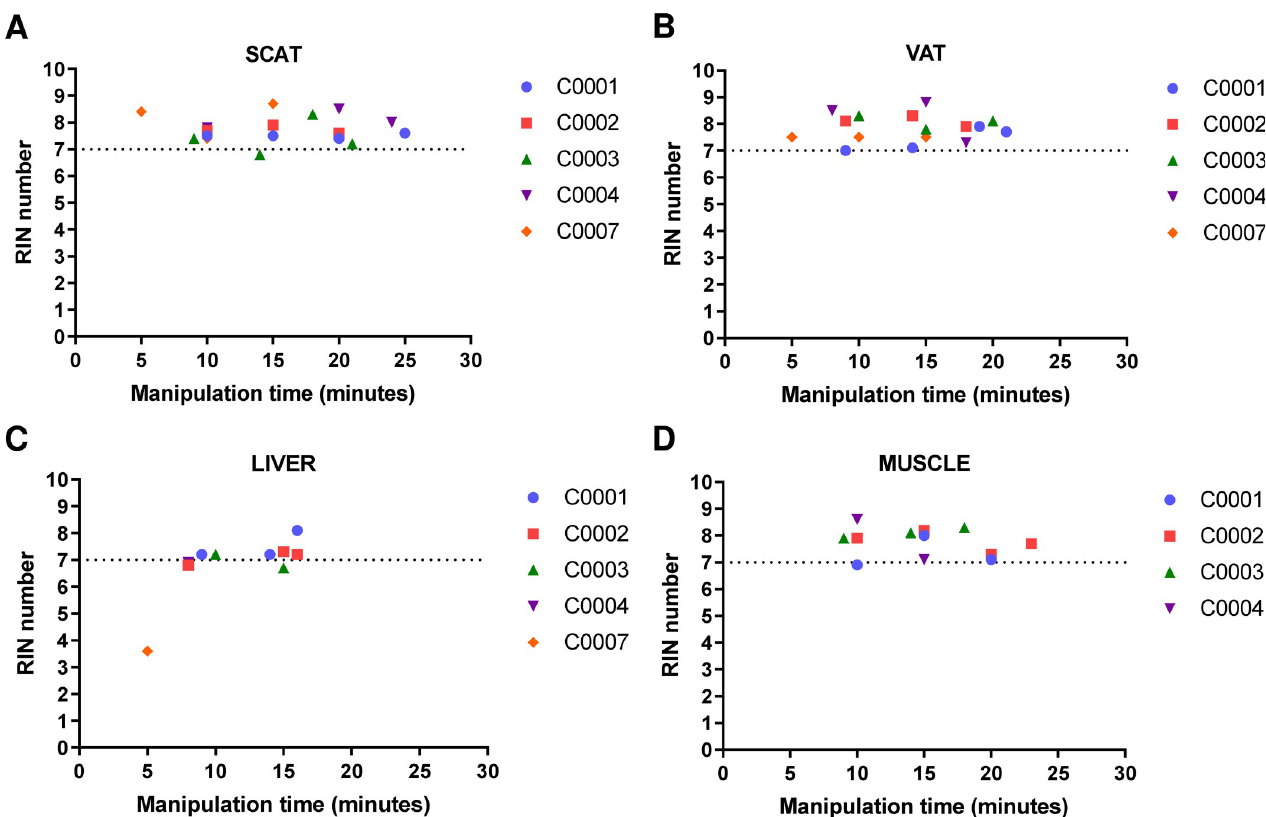
Fig 3. RIN according to handling time for tissue preparation for the first five patients. RNA was extracted from frozen tissues. RIN was shown according to handling times of liver, muscle, SCAT and VAT samples resected from the first five patients, before snap–freezing. The handling times between tissue resection and snap–freezing were: � 10, � 15 and � 20 minutes (all tissues) and � 25 minutes (adipose tissues only). SCAT, sub–cutaneous adipose tissue; VAT, visceral adipose